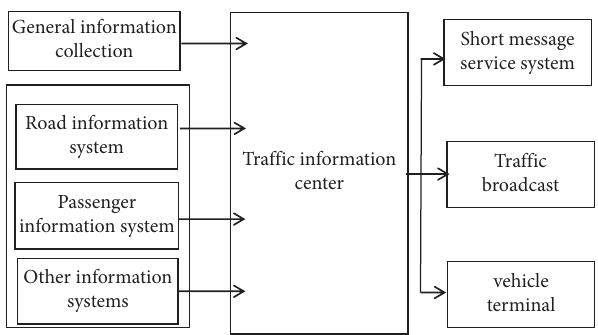
Figure 4: Intelligent transportation service system